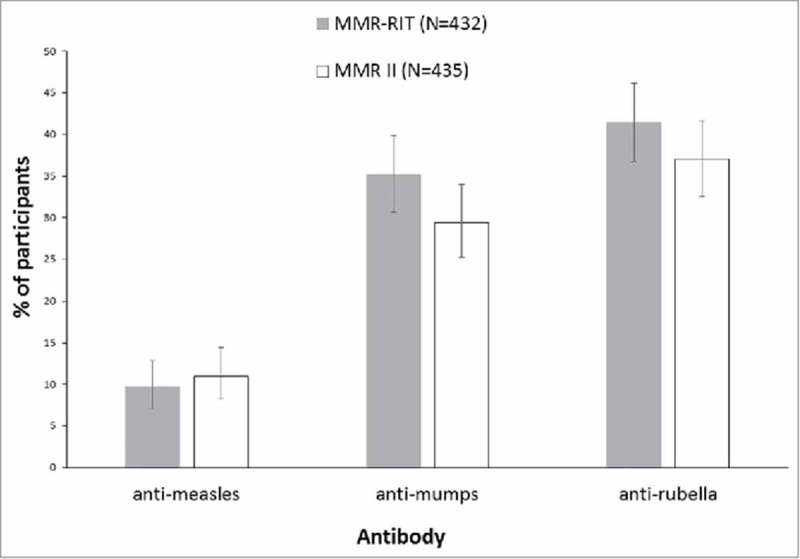
Percentage of participants who achieved a 4-fold or greater increase in anti-measles, anti-mumps, or anti-rubella virus antibody concentrations at Day 42 (ATP cohort for immunogenicity). Footnote: N, number of participants with both pre- and post-vaccination available results; ATP, according-to-protocol.For participants with a seronegative status at pre-vaccination, a 4-fold rise in antibody concentration is defined as 4 times the cut-off level of the assay. Cut-off levels for anti-measles, anti-mumps and anti-rubella virus antibody concentrations are 150 mIU/mL, 5 EU/mL and 4 IU/mL, respectively. The error bars represent the upper and lower limits of the two-sided 95% confidence intervals obtained using the Clopper Pearson method.